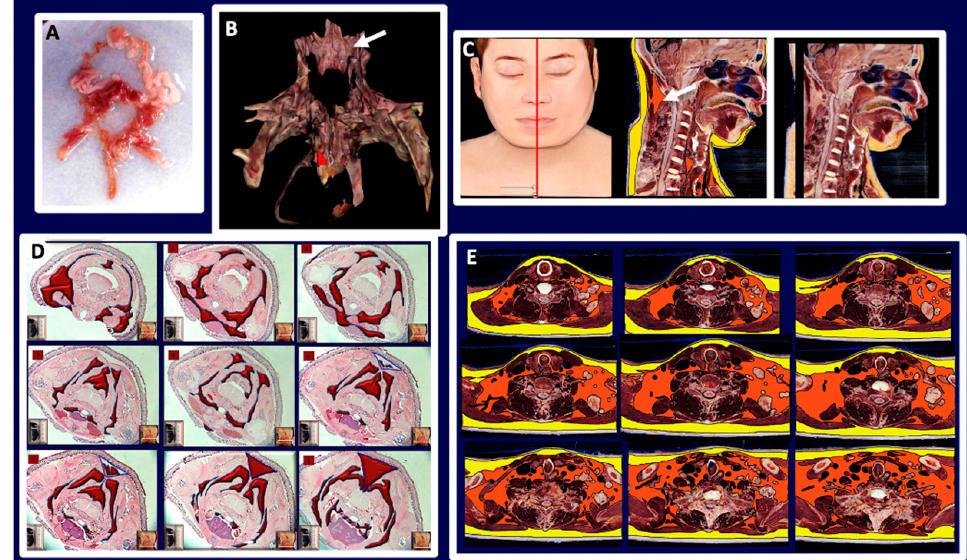
Figure 5. Comparative data between mouse and human fat neckerchief. ( A ): Human fat neckerchief. ( B ): 3D reconstruction of the fat areas obtained through the entire set of Vicky’s cervical sections. Dorsal view, the deep neck brown fat mass is indicated by the arrow. ( C ): Vicky median sagittal section (left panel) in which the subcutaneous fat is highlighted in yellow and the brown fat in orange (central panel). The arrow indicates the deep neck brown fat also shown in ( B ). The right panel shows the original section with no highlights. ( D , E ) show a comparison between the brown fat forming the neckerchief in a mouse and in Vicky serial sections (original sections are shown in Supplementary Figures S7 and S15). Bars: 15 mm in ( A ), 60 mm in ( B ), 14 cm in ( C ), 15 mm in ( D ), 6 cm in ( E ).